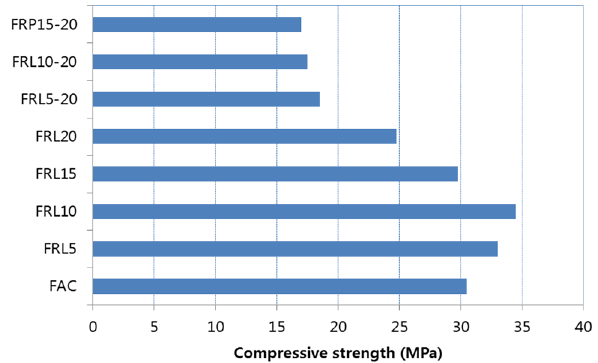
Fig. 2 Compressive strength variation of various systems of concrete.